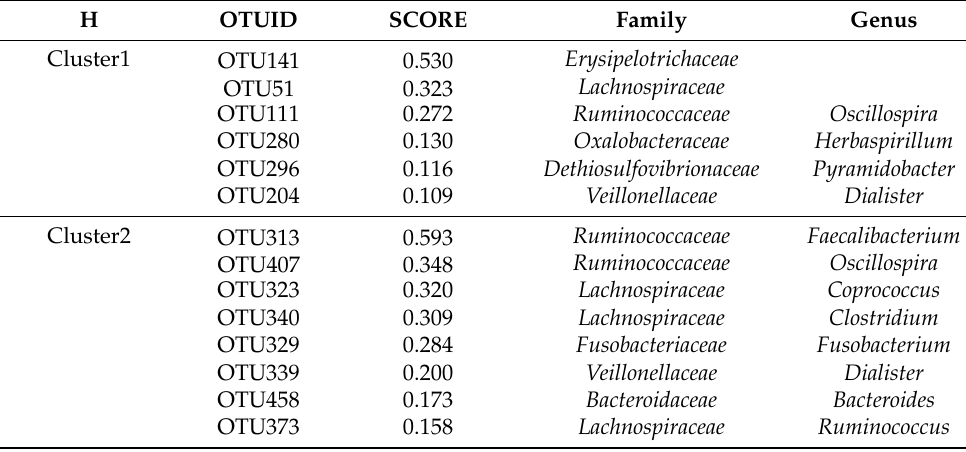
Table A5. The score value and core flora of GMPR+Spectrum in